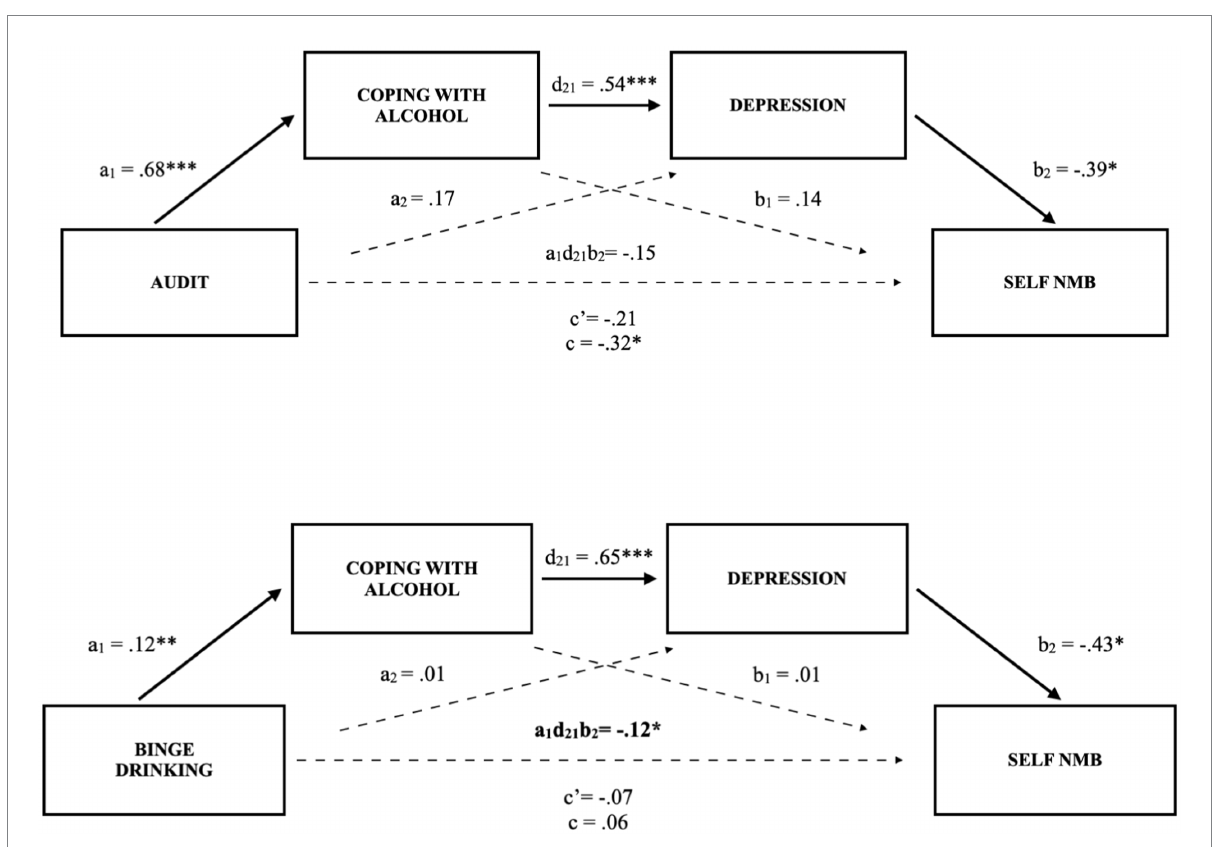
FIGURE 1 Serial multiple mediation model of the relations between problematic drinking (AUDIT scores) and binge drinking with negative self-referent memory bias (self-NMB) through coping motivations and depressive symptoms in undergraduate female students. (Study 1). Solid lines and bolded parameters reflect significant relations: * p < 0.05, ** p < 0.01, *** p <